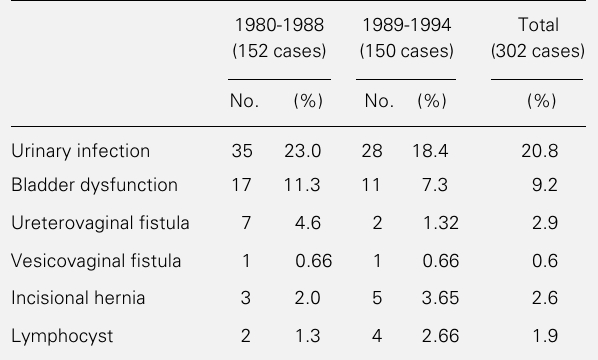
Table 3 - Postoperative complications of radical hysterectomy pa-